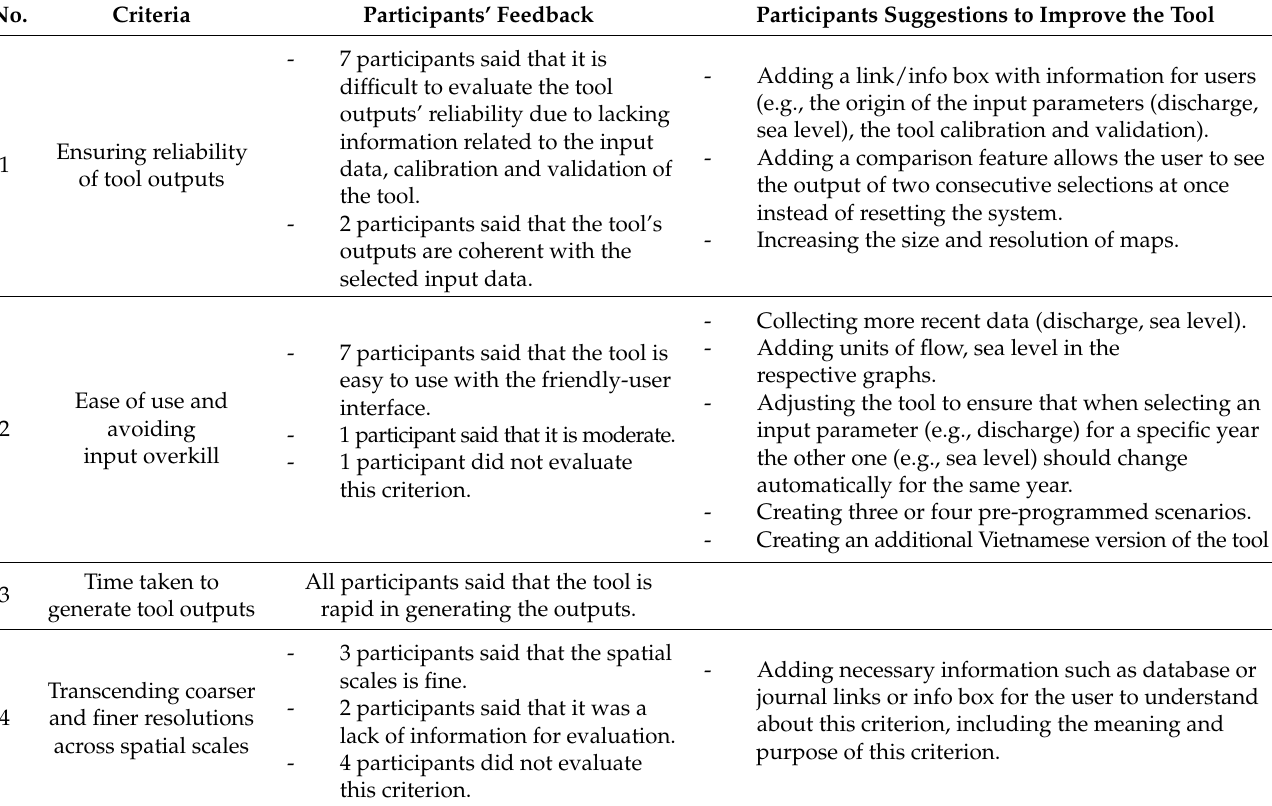
Table 2. Summary of participants’ feedback and suggestions for improving the Inform tool. No. Criteria Participants’